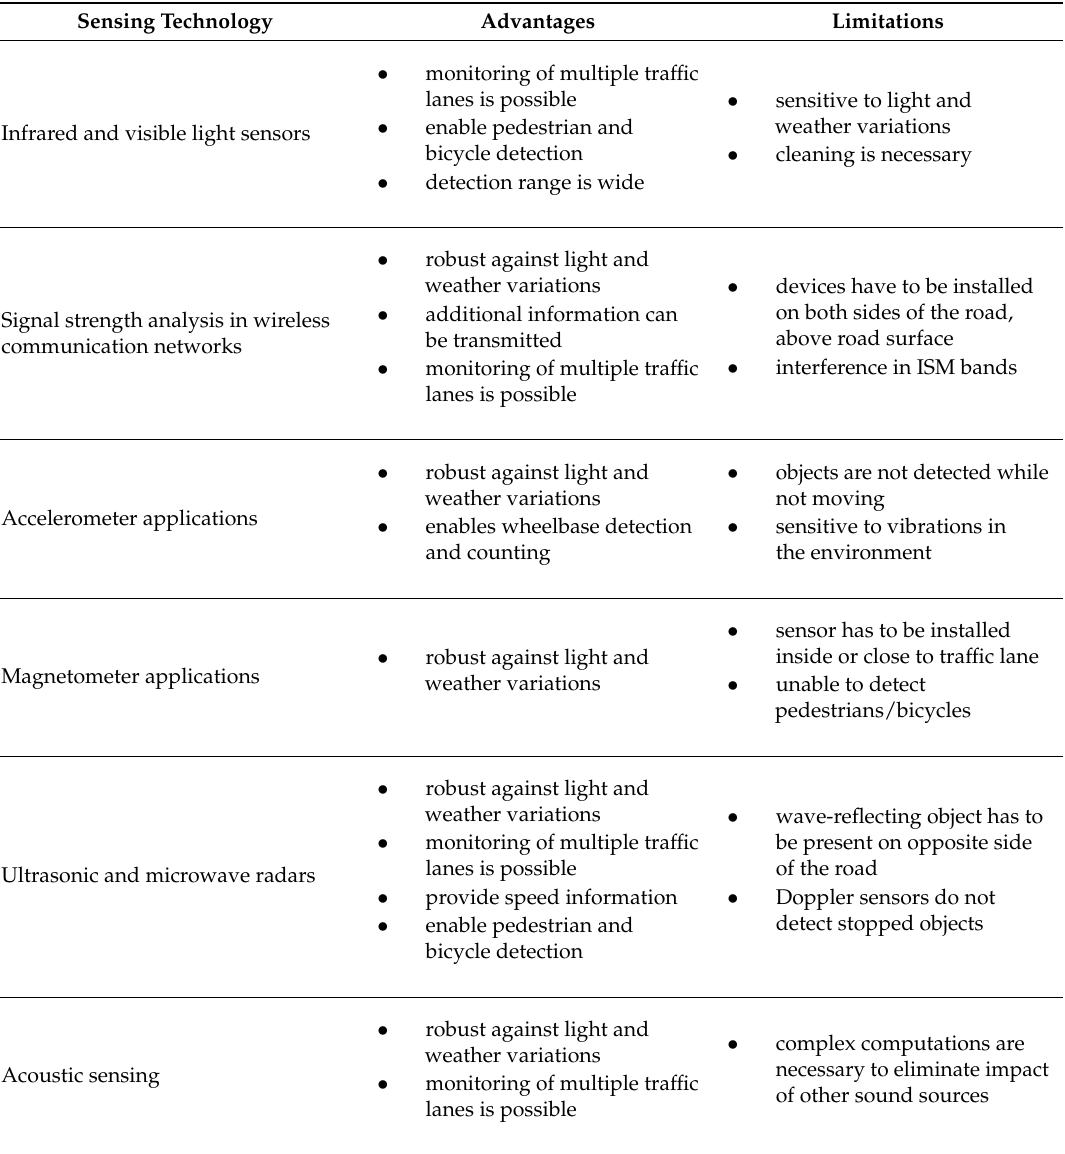
Table 3. Advantages and limitations of low-cost sensing technologies for road traffic